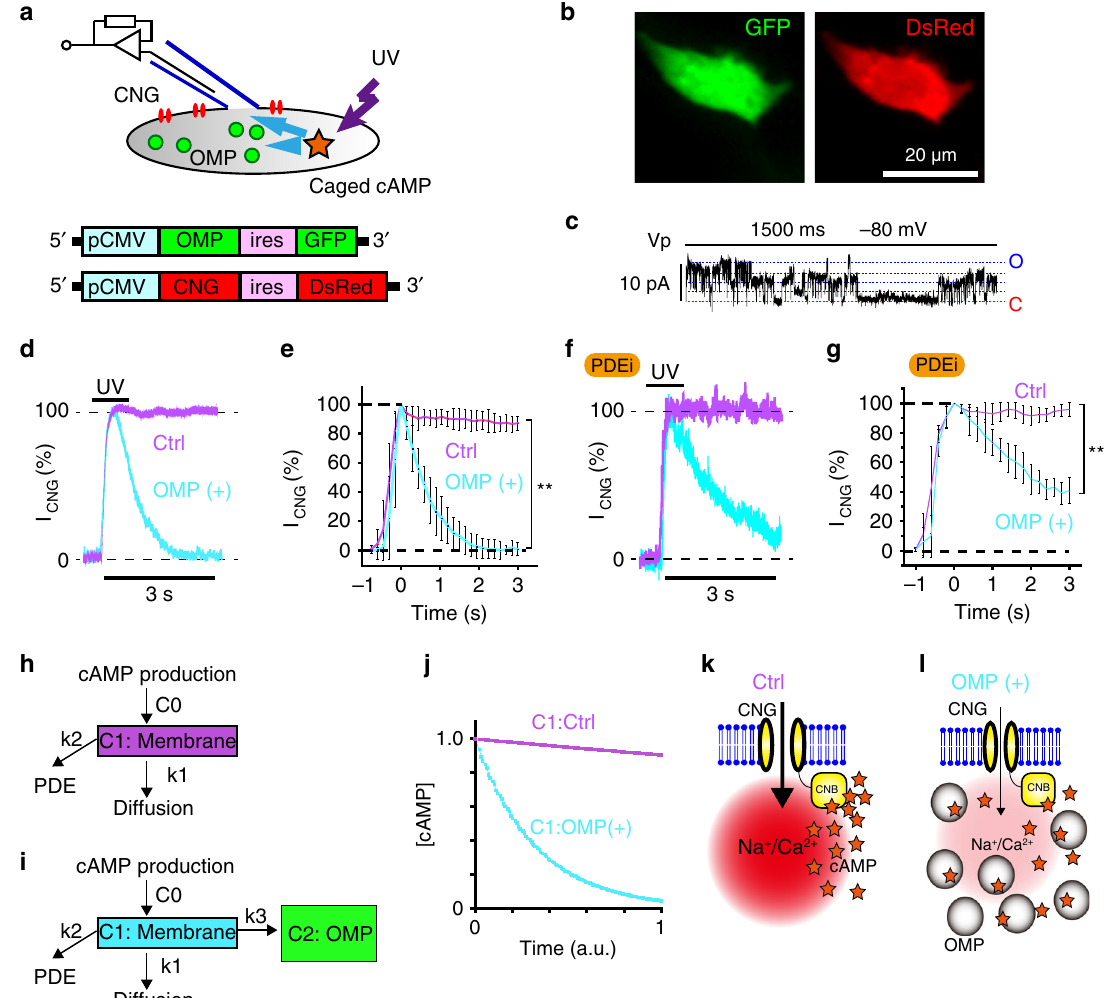
Fig. 3 OMP sequesters a cytosolic cAMP surge. a Scheme of the photo-uncaging of cAMP under whole-cell patch-clamp recording and the vectors used for the experiment in ( d – g ). Transfected HEK293T cells coexpressed GFP and DsRed with OMP and CNGA2, respectively, under the control of IRES. b Con fi rmation of fl uorescent protein expression in transfected cells. Experiments were repeated three times with similar results. c CNGA2 channel activities in the cell-attached con fi guration. The red dashed line indicates the closed state. The blue dashed lines indicate the open state. d Representative UV-induced CNG currents from one cell in the absence (Ctrl) or presence of OMP, overlaid for each condition. e Normalised CNG currents (% to peak) induced by the photo-uncaging of cAMP; n = 13 and 11 cells for Ctrl and OMP( + ) cells, respectively. Statistics: one-sided unpaired T test; activation time constant, P = 0.38; decay %, P = 0.0001. f Representative UV-induced CNG currents from one cell in the presence of PDEi: overlaid for Ctrl and OMP( + ). g Normalised CNG currents (% to peak) induced by the photo-uncaging of cAMP in the presence of PDEi. Mean± s.d.; n = 4 and 4 cells for Ctrl and OMP( + ) cells, respectively. One-sided unpaired T test; activation time constant, P = 0.78; decay %, P = 0.0002; n = 4 and 4 cells for recordings with and without OMP, respectively. h Single-compartment model without OMP. i Two-compartment model with OMP. k1 – k3, the diffusion constant (k1), cAMP-eliminating activity of PDE (k2) and cAMP capture of OMP (k3). Assuming that k3 was much larger than k2, cAMP dissociation from OMP was ignored within this duration. j Simulated cAMP in the membrane compartment (C1). a.u. arbitrary unit of time. Time and [cAMP] are given in arbitrary units in the fi gures. k , l Schematics of the CNG channel activation time course; ( k ) prolonged Na + /Ca 2 + in fl ux without OMP and ( l ) small Na + /Ca 2 + in fl ux through rapidly deactivated CNG channels via cAMP buffering with OMP. Mean ±